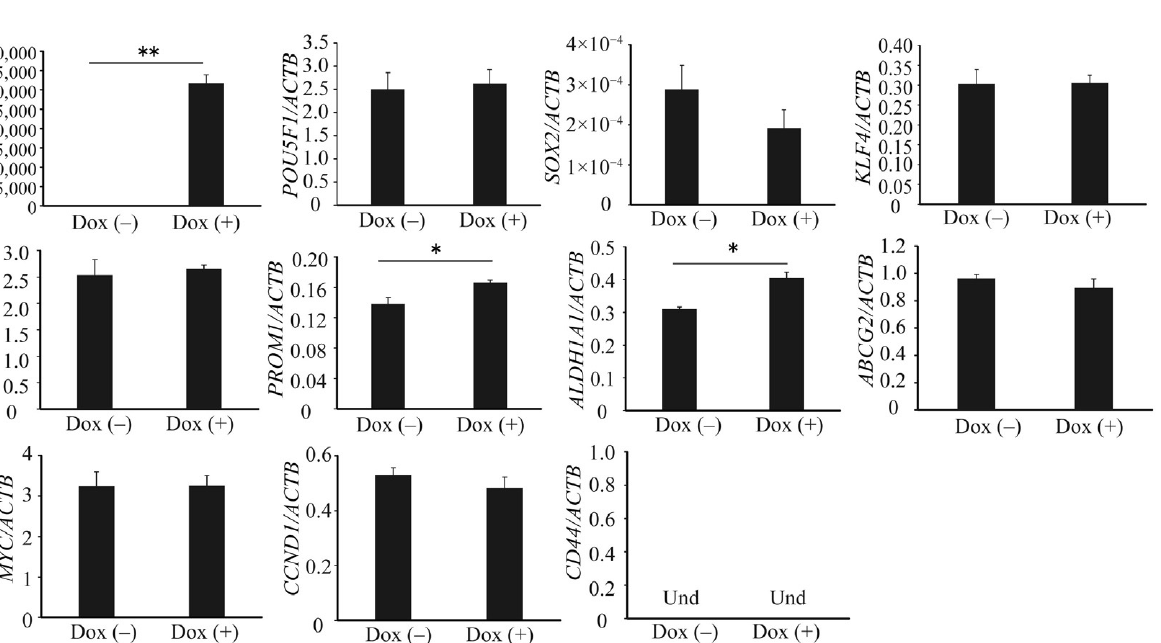
Figure 3. ADAM32 increases expression levels of stem cell-related genes. The expression levels were evaluated with real-time RT-PCR by using total RNA prepared from ( a ) HepG2 Tet treated without or with Dox, ( b ) HepG2, and ( c ) HBCs transiently transfected with shRNA or siRNA and incubated for 48 h. Relative gene expression levels were calculated as the ratio relative to ACTB levels. Values are summarized by mean and SE (n = 3); * p < 0.05; ** p < 0.01; Und, undetermined.